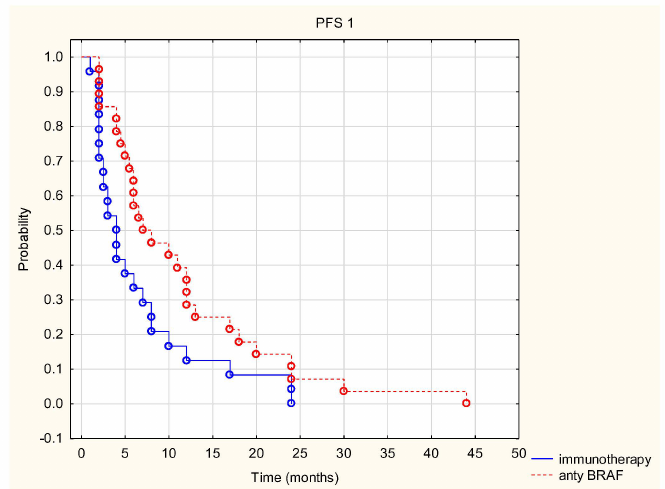
Figure 3. Time to first progression after first-line treatment (PFS1) in patients treated with anti-BRAF and